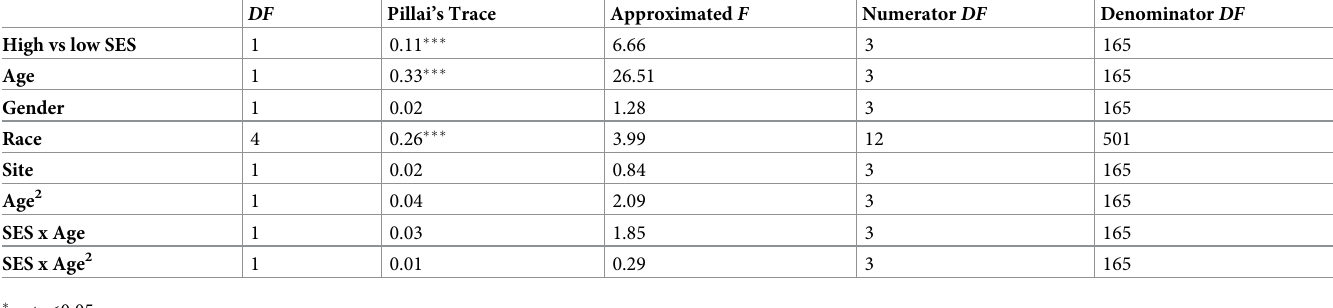
Table 6. MANCOVA of working memory measures as a function of low and high SES controlling for race ( N = 185). DF